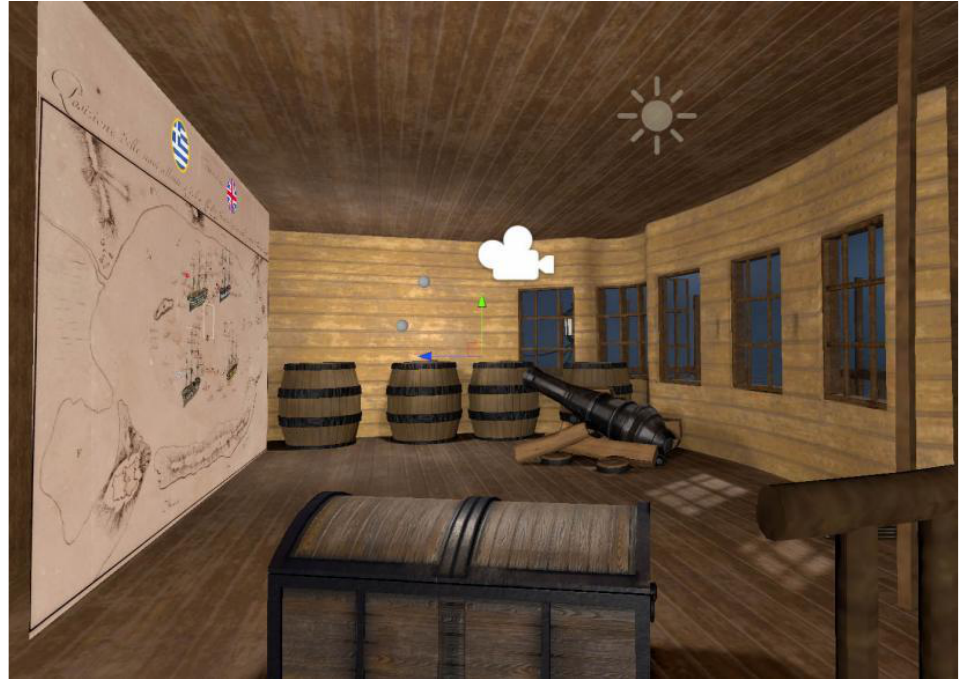
Figure 1. The introductory scene of the VR application “The Ships of Navarino”. Screenshot Figure 1 . The introductory scene of the VR applicatio n “The Ships of Navarino”. Screenshot from from Unity3d.